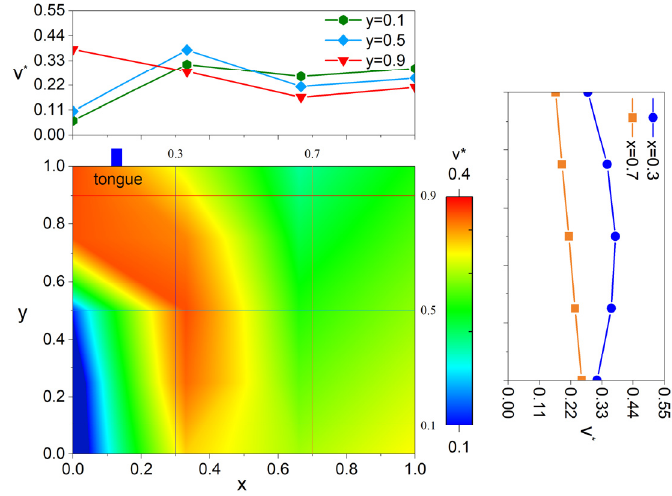
Figure 15. Reconstruction of flow field under 1.2 Φ N .